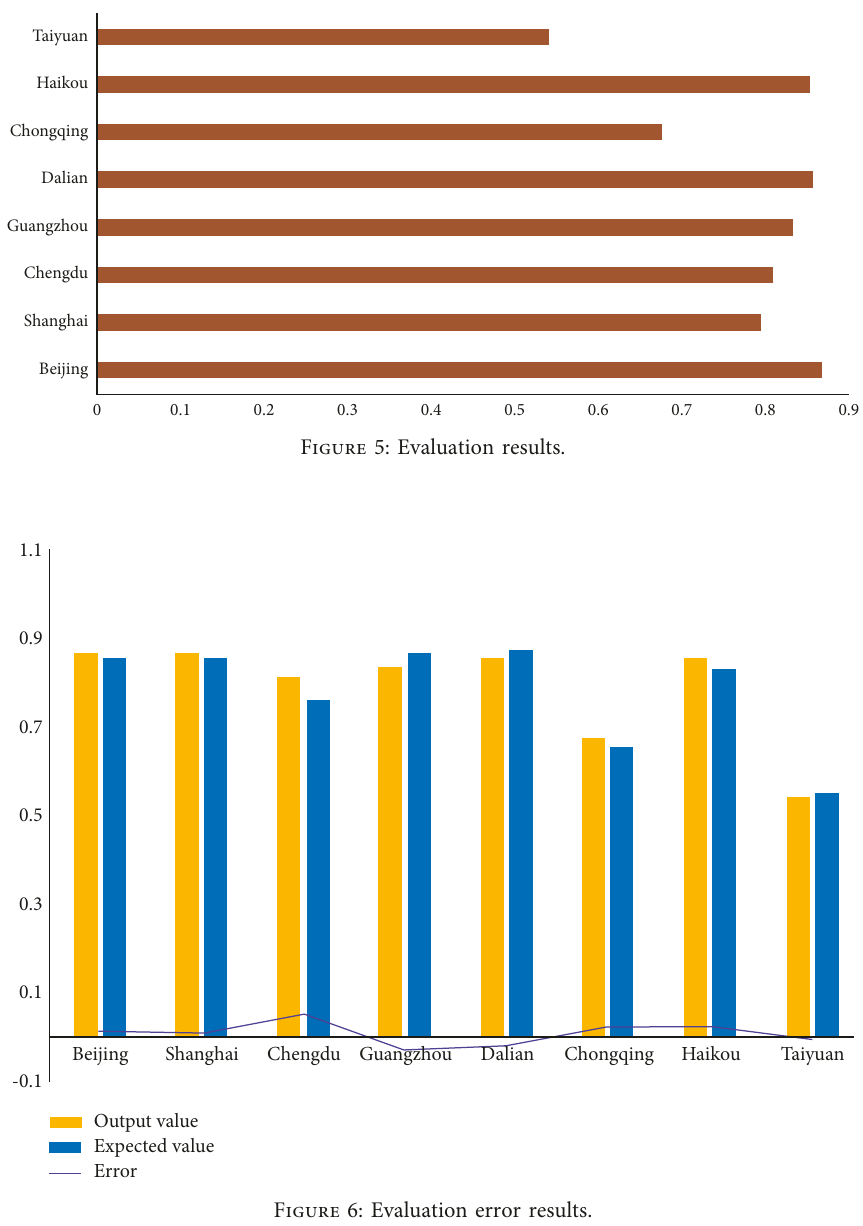
Figure 6: Evaluation error